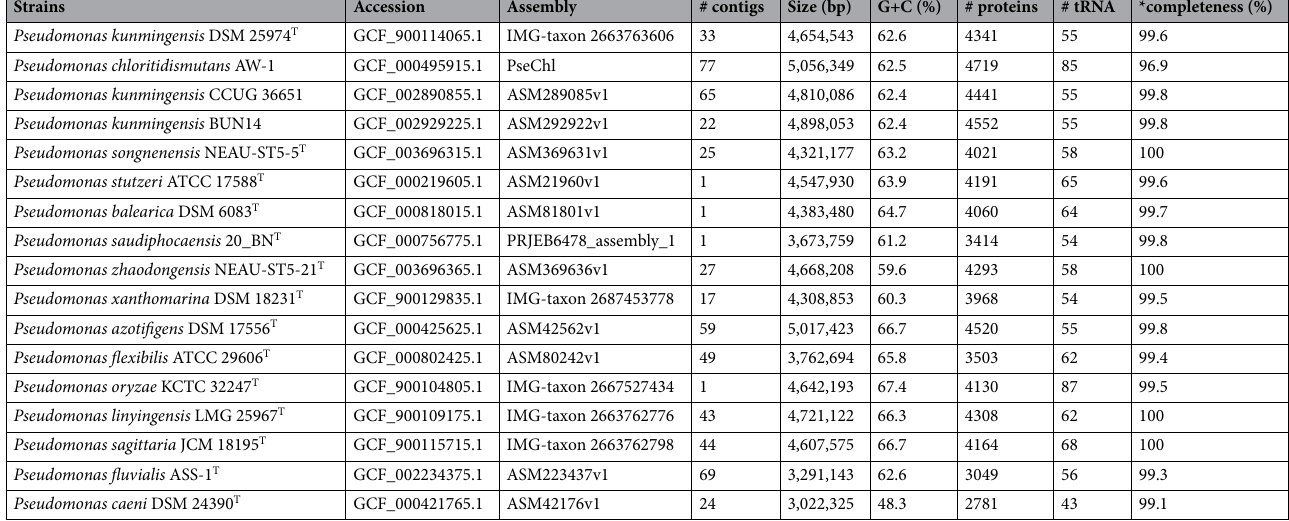
Table 1. Genomic comparison with related Pseudomonas strains obtained from the NCBI database.